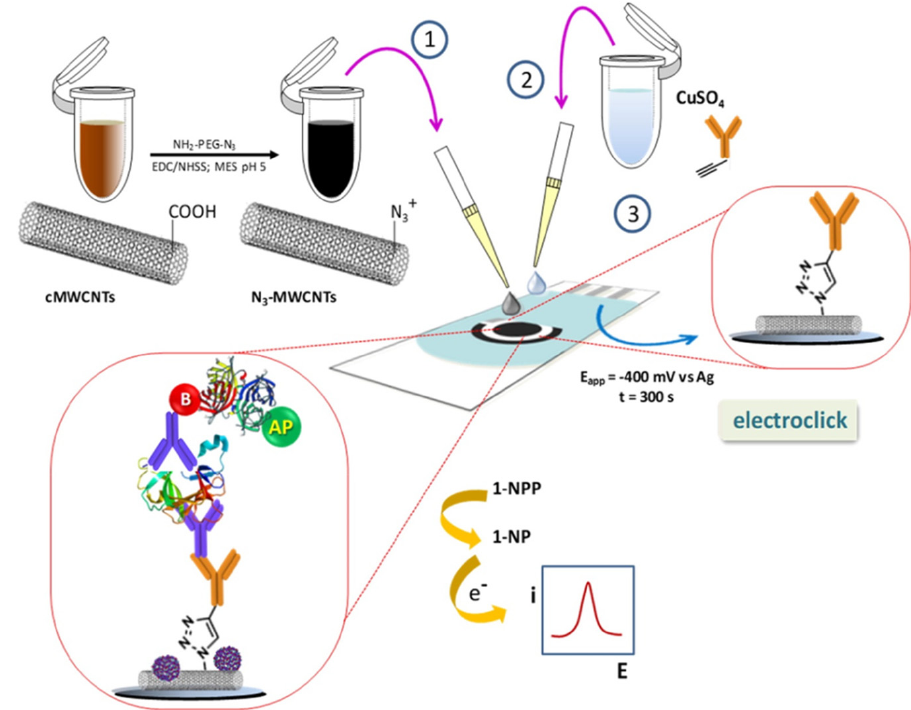
Figure 6. Sandwich immunoplatform for the DPV determination of IL-1 β using IgGs-MWCNTs